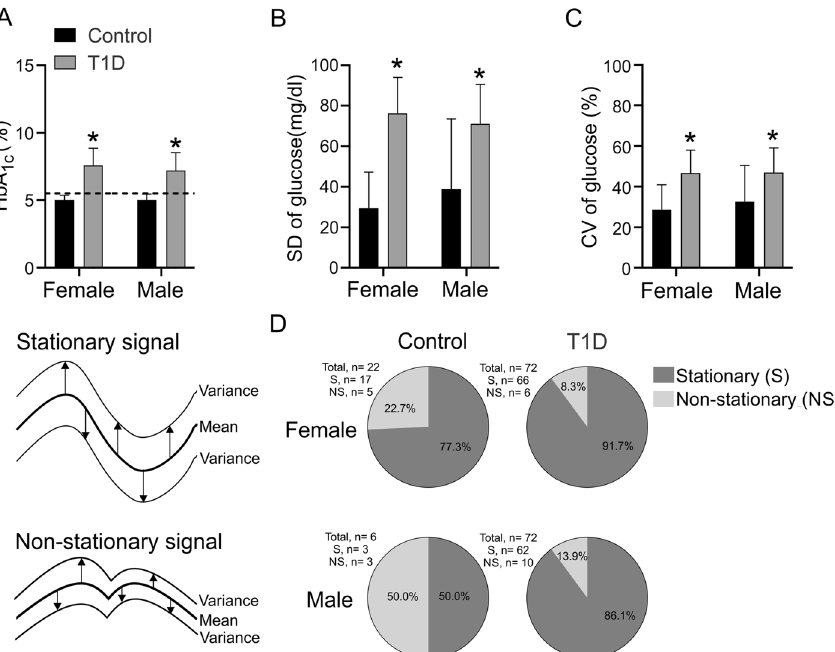
Figure 2. Glycosylated hemoglobin (HbA 1c ), glucose variability and prevalence of stationary and non- stationary glycemic oscillatory pattern in females and males with T1D and control participants. ( A ) HbA 1c is increased in T1D patients independent of sex. Indeed, T1D females and male patients showed a significant increase of HbA 1c compared to her/his matched Control group (Two ways ANOVA, following Holm-Sidak posthoc; F (DFn: 2, DFd: 181) = 32.43; p < 0.0001). ( B ) T1D females and males patients display an increase of standard deviation (SD) of glycemia compared to her/his matched Control group (Two ways ANOVA, following Holm-Sidak posthoc; F (DFn: 2, DFd: 180) = 35.30; p < 0.0001). ( C ) Compared to her matched Control group, T1D female subjects showed a significant increase of coefficient of variation (CV) of glycemia (Two ways ANOVA, following Holm-Sidak posthoc; F (DFn: 2, DFd: 180) = 15.89; p < 0.0001). Male with T1D showed a significant difference compared to his control group (Two ways ANOVA, following Holm-Sidak posthoc; F (DFn: 2, DFd: 180) = 15.89; p < 0.0001). ( D ) Left panel showed an example of stationary and non-stationary oscillatory signal. Stationary signal is characterized by a constant variance, and contrarily, non-stationary signal did not display a constant variance. Right panel showed the prevalence of stationary and non-stationary glycemic oscillatory pattern for 6 days of analysis. Stationary and non-stationary signals were analyzed by R Core Team (2020) 39